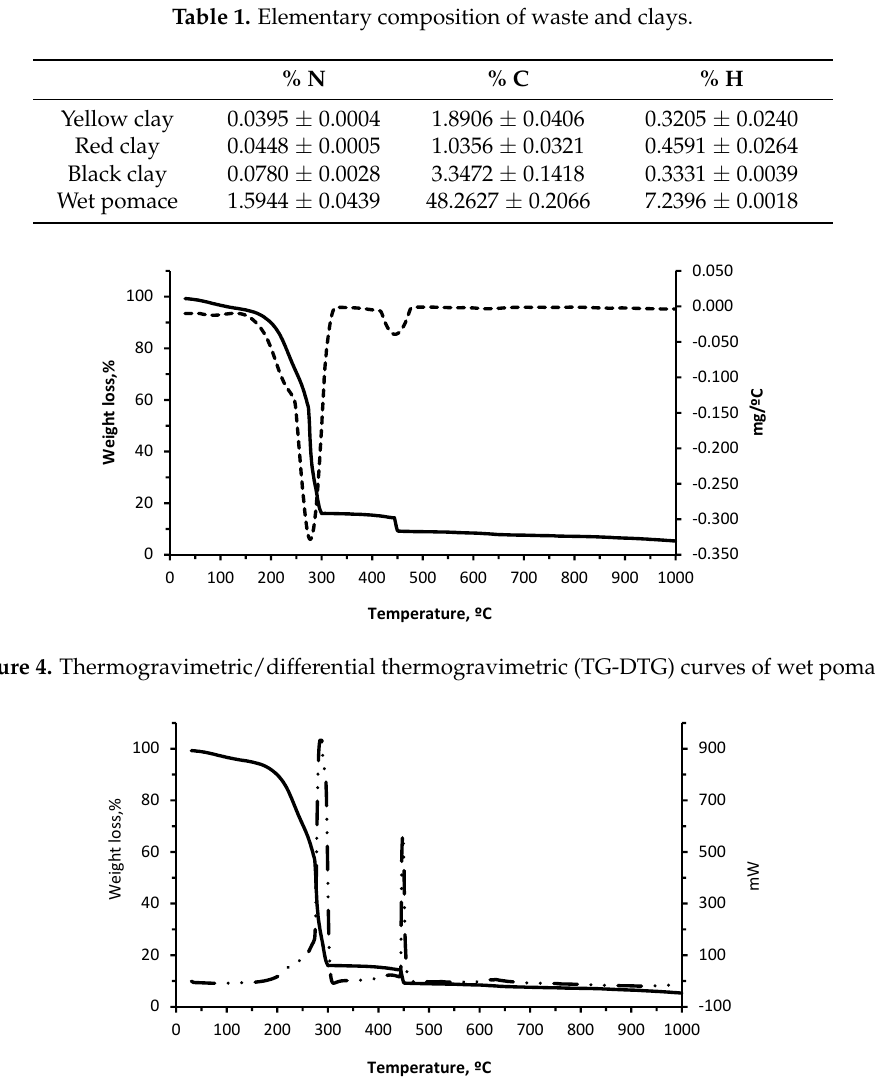
Figure 5. Thermogravimetric/differential scanning calorimetry (TG-DSC) curves of wet pomace.